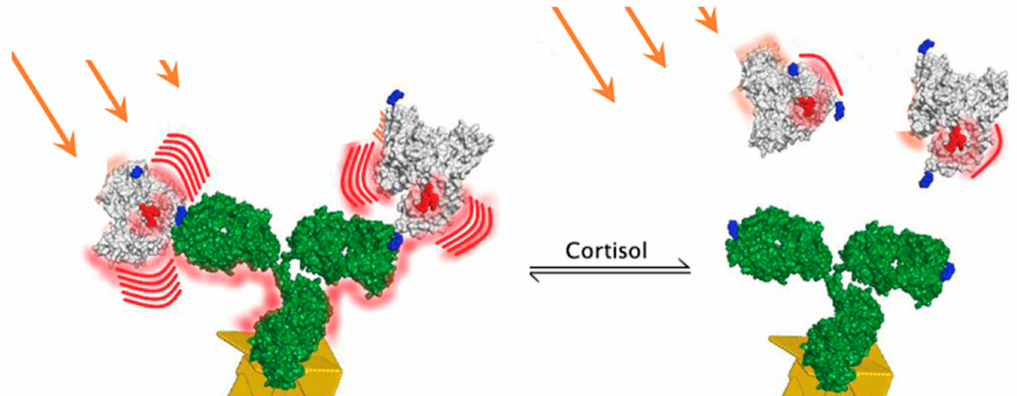
Figure 6. Competitive equilibrium binding of cortisol to the surface-bound monoclonal antibodies to cortisol. Fluorescence intensity of the cortisol–BSA–fluorophore reporter is enhanced in close proximity to the Au nanostructured film surface. When free cortisol is present, the fluorescence intensity gradually drops, allowing the concentration fluctuations to be monitored over time in vitro (from [39] under CC BY-NC-ND